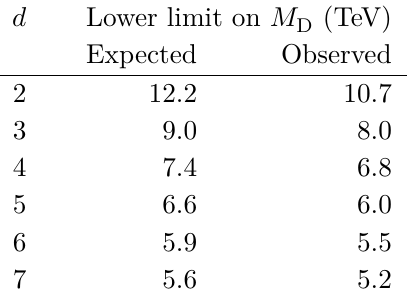
Table 3 . Lower limits at 95% CL on the fundamental Planck mass M number of extra dimensions d